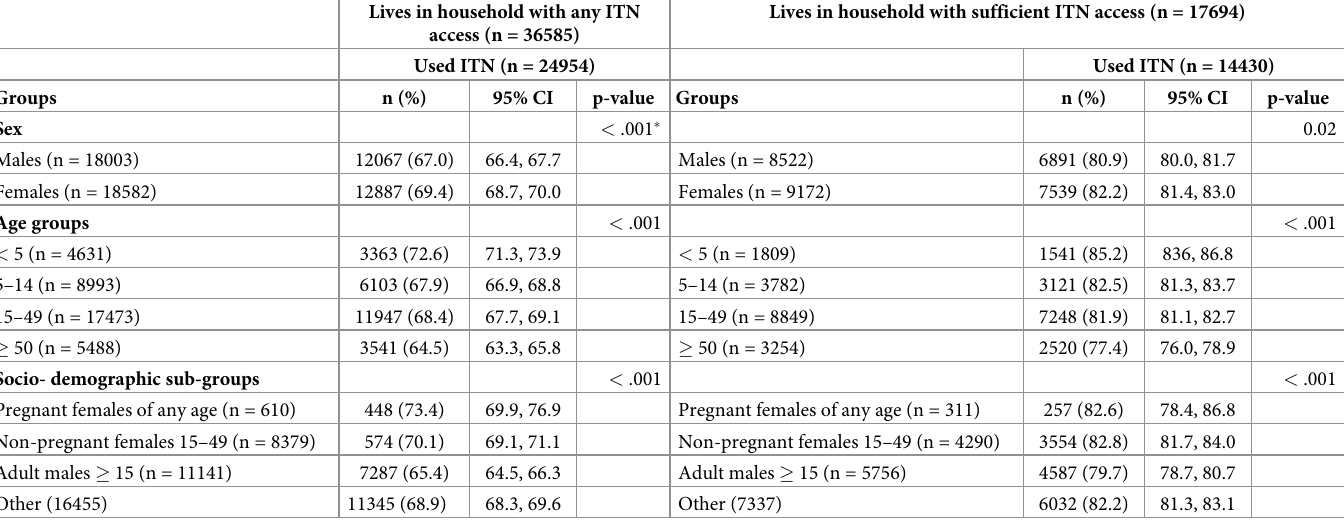
Table 2. Proportion of ITN use (sleeping under ITNs the prior night) and non-use among each socio-demographic sub-group who belonged to households with any and sufficient ITN access in eastern Myanmar, 2013 (n = 36585). Lives in household with any ITN Lives in household with sufficient ITN access (n = 17694) access (n = 36585) Groups